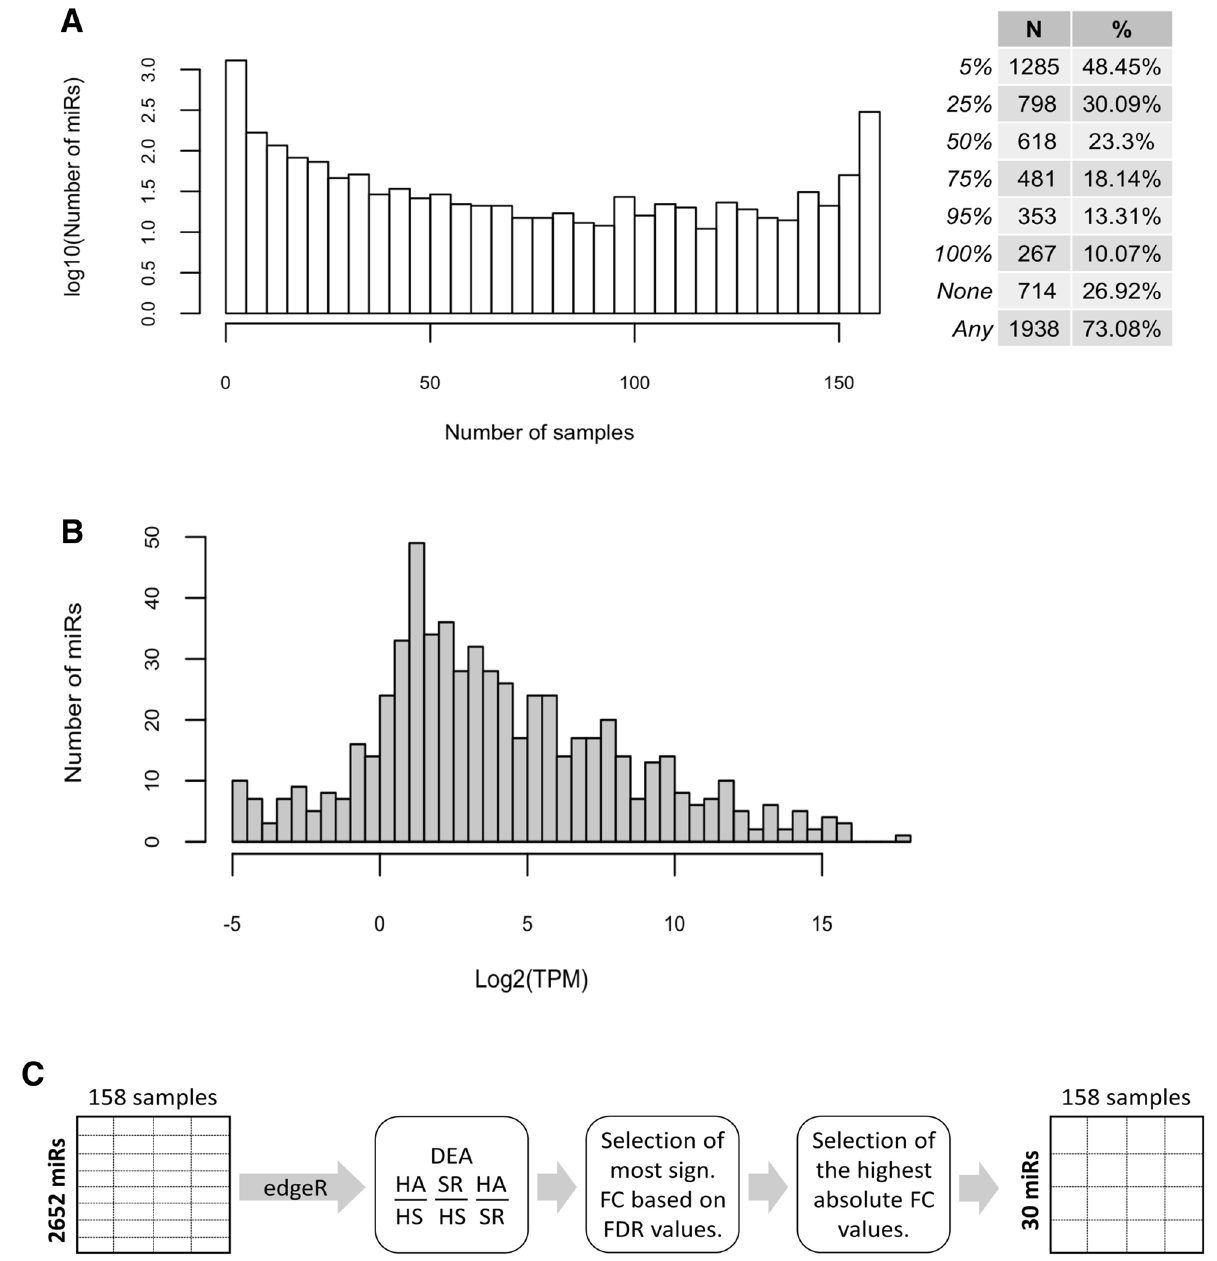
Figure 1. Summary of analysis of EXAMIN AGE data. ( A ). Distribution of the number of individual miRNAs detected in specific numbers of samples and number and percentage of mature miRs identified in the indicated proportions of samples. ( B ). Numbers of miRNAs with specific values of median expression across samples (miRNAs with zero median expression are not shown). ( C ). Outline of the comparison of miRNA expression between groups of patients. DEA differential expression analysis, HA healthy active, HS healthy sedentary, SR sedentary at increased CV risk, FC fold change, FDR false discovery physiological parameters indicating a positive health status. The sole exception to this finding was miR-342-3p. miR-342-5p has previously been identified as an exerkine even if miR-342-3p and miR-342-5p might differ in their functionality 27 . In contrast, PC2 appears to be defined primarily by differences in miRNA expression of disease traits, without specific associations with health status, except of sportive walking and HDL (Fig. 4A,B). By analysing the principal component analyses on the differentially expressed miRNAs without inclusion of the CV risk factors, the first two principal components even explained 27% and nearly 20% of the variance in the data (Supplementary Fig. S2).